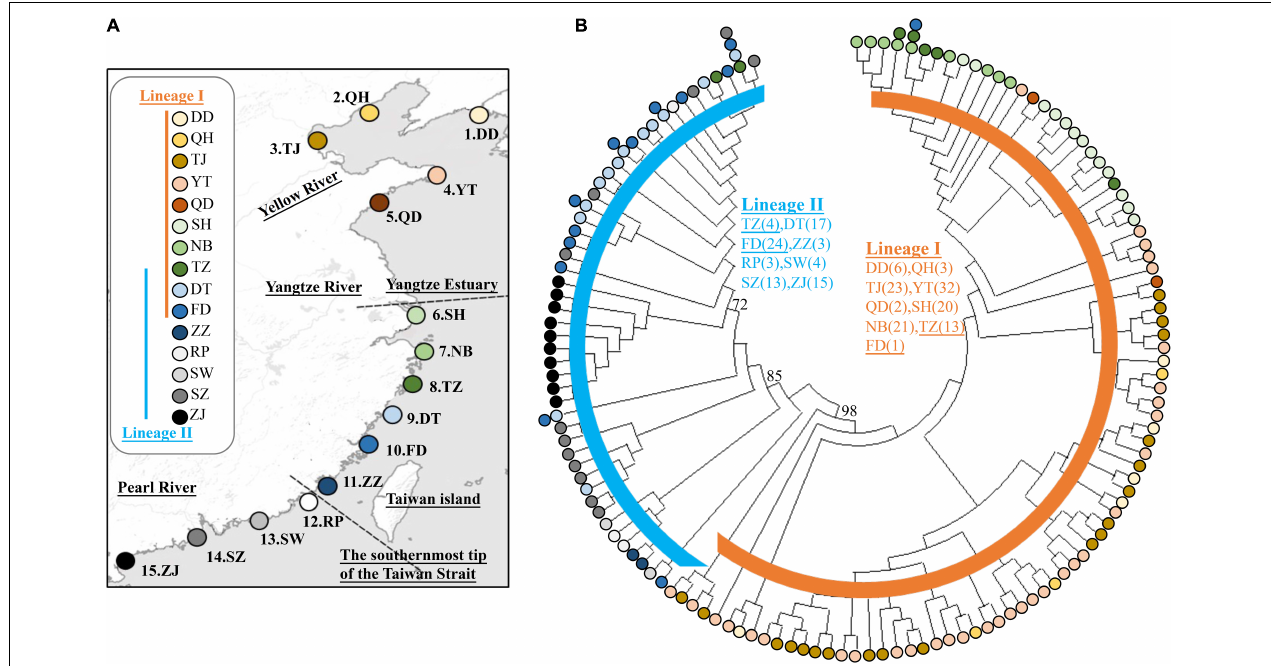
FIGURE 1 | (A) The sampling localities of Tridentiger bifasciatus along the coast of the China Seas are indicated by • . Refer to Table 1 for the abbreviations of the localities. (B) The maximum likelihood tree and the distribution of the lineages based on mitochondrial DNA cytochrome b and d-loop sequences. The numbers at the nodes are the bootstrap values. Bootstrap values less than 70% are not shown. TABLE 1 | Genetic diversity of Tridentiger bifasciatus in the China Seas. mtDNA nuDNA population